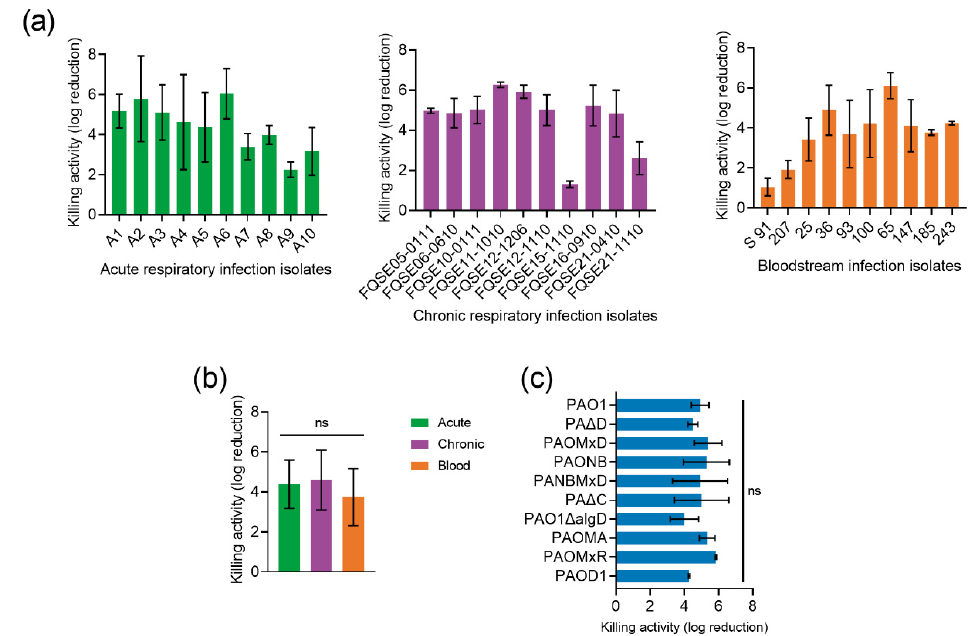
Figure 4. Impact of P. aeruginosa genetic variability on P88 activity. ( a ) Bactericidal activity of 10 µ M P88 on 10 5 CFU/mL P. aeruginosa clinical strains suspensions (in 20 mM NaPiB, pH 6.0, 150 mM NaCl) incubated for 2 h at 37 ◦ C. ( b ) Mean activity of P88 against the clinical isolates from different origins. One-way ANOVA followed by Tukey post-test was applied to analyze statistical differences. ( c ) Activity of 10 µ M P88 on 10 5 CFU/mL P. aeruginosa PAO1 and a collection of isogenic mutants. One-way ANOVA and Dunnett post-test were used to detect statistical differences with respect to the activity against PAO1. ns = Nonsignificant difference.